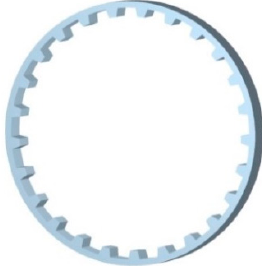
Figure 4. Semi-autogenous grinding (SAG) mill model.